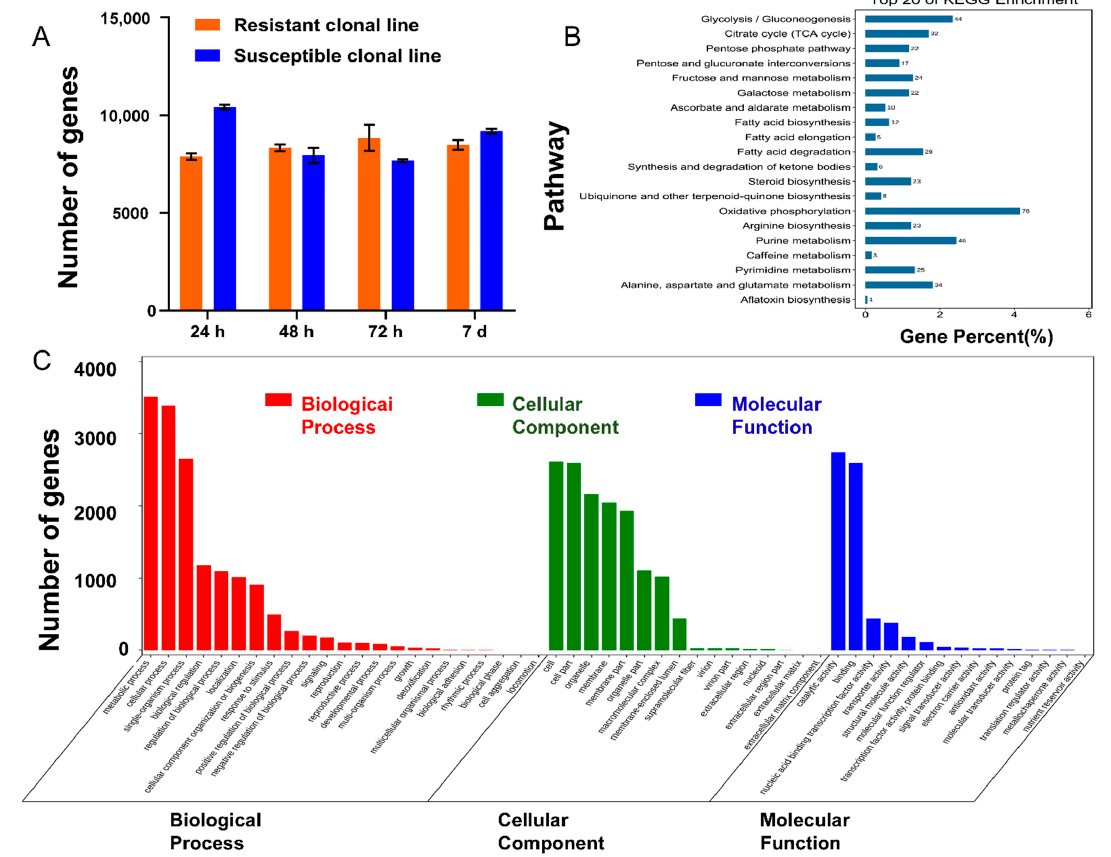
Figure 8. Transcriptome analyses of F. proliferatum L1after inoculation. ( A ) Number of fungal genes detected at four time points after inoculation. The values are presented as the mean ± SE. Values of three independent biological replicates per time point. ( B ) KEGG enrichment analyses of genes detected in F. proliferatum L1. ( C ) GO enrichment analyses of genes detected in F. proliferatum L1. GO, gene ontology; KEGG, Kyoto Encyclopedia of Genes and Genomes; SE, standard